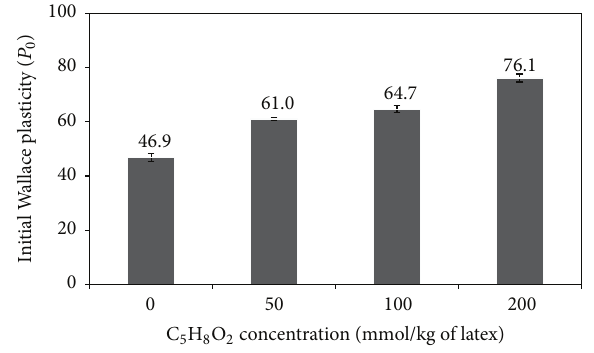
Figure 7: Mooney viscosity of NR obtained from the fresh NR latex treated with different concentrations of C 5 H 8 O 2